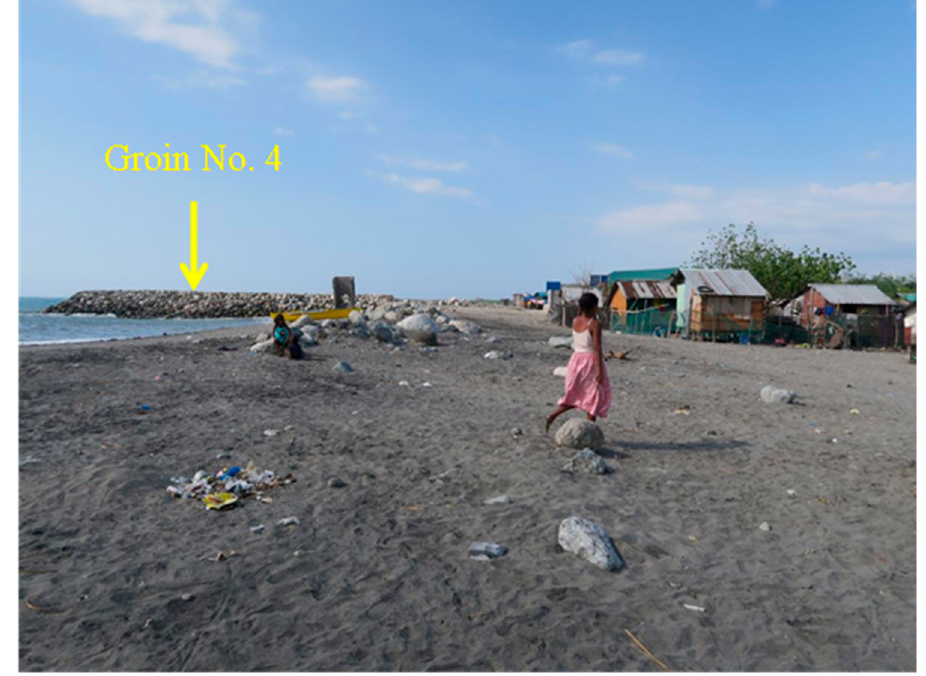
Figure 19. Picture of groin No. 4 taken from behind groin No. 5. In contrast, the shoreline south of this groin retreated as a water area can be identified landward (left) end of the groin (Figure 20). Thus, the construction of the six groins was